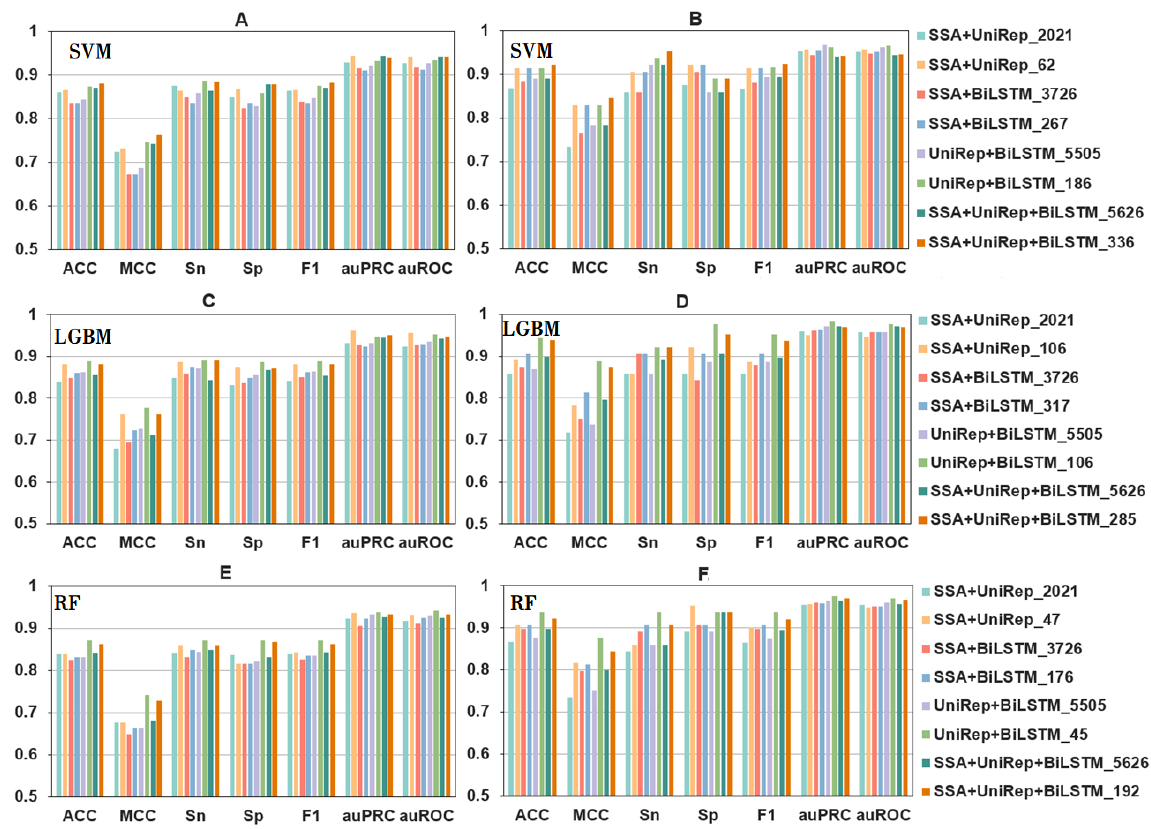
Figure 3. The performance metrics of fusion features using a range of selected features and different algorithms. Panels ( A , C , E ) show 10-fold cross-validation results, and panels ( B , D , F ) are independent test results. Please note that the same colors represent different selected features in the different panels. Refer to the codes directly underneath a panel for the appropriately selected feature/model combination codes.